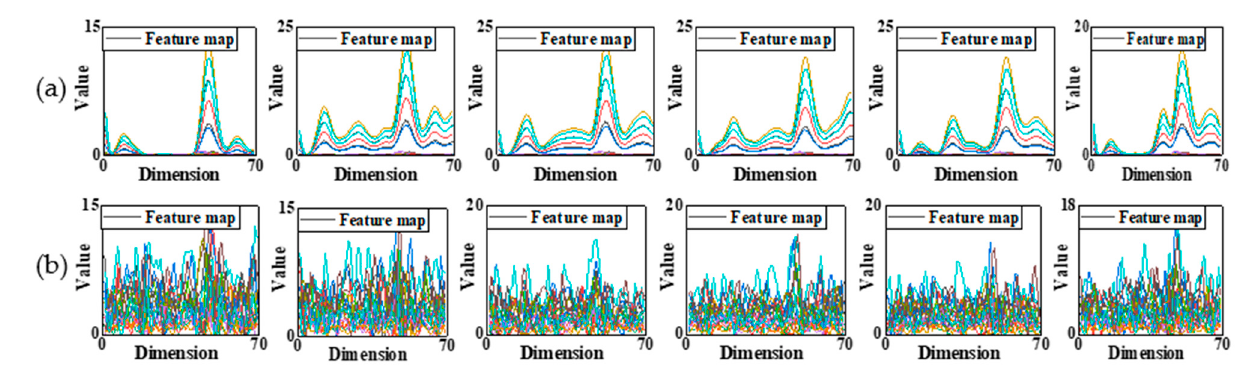
Figure 17. Feature maps. ( a ) SNR = 100 dB; ( b ) SNR = 60 dB.